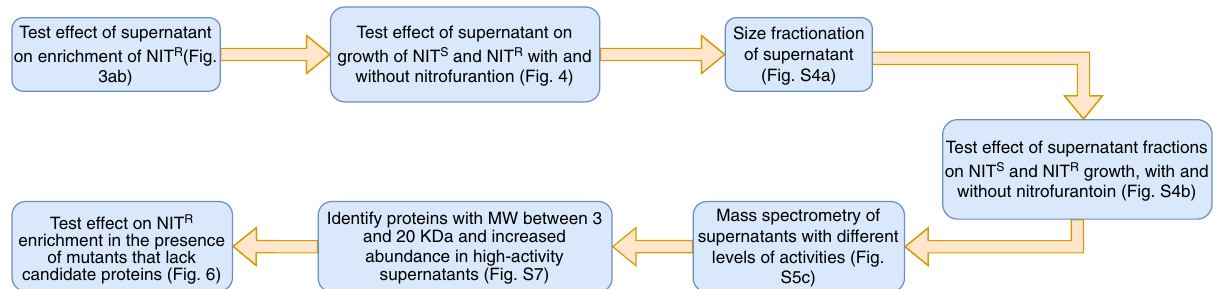
S5c)Identify Fig. 5 Identi fi cation of YydF and YorD. Flow chart explaining the method used to identify and test proteins or peptides that has a signi fi cant effect on E. coli NIT resistance